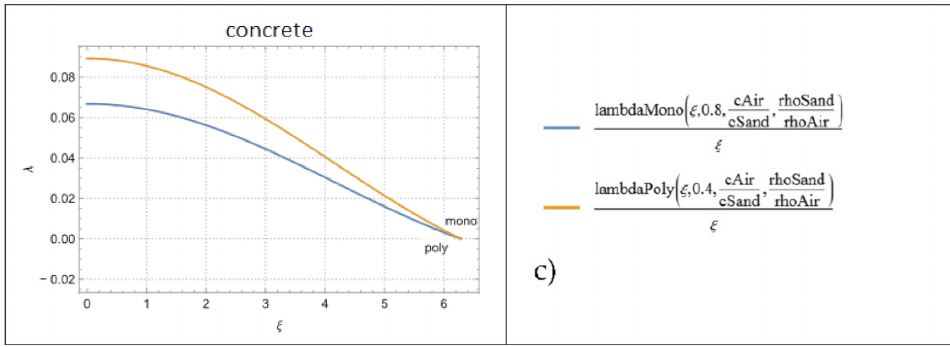
Figure 12. Comparative characteristics ( a ) for gas water, ( b ) for brick, ( c ) for concrete. The total concentration for mono and polydisperse media is